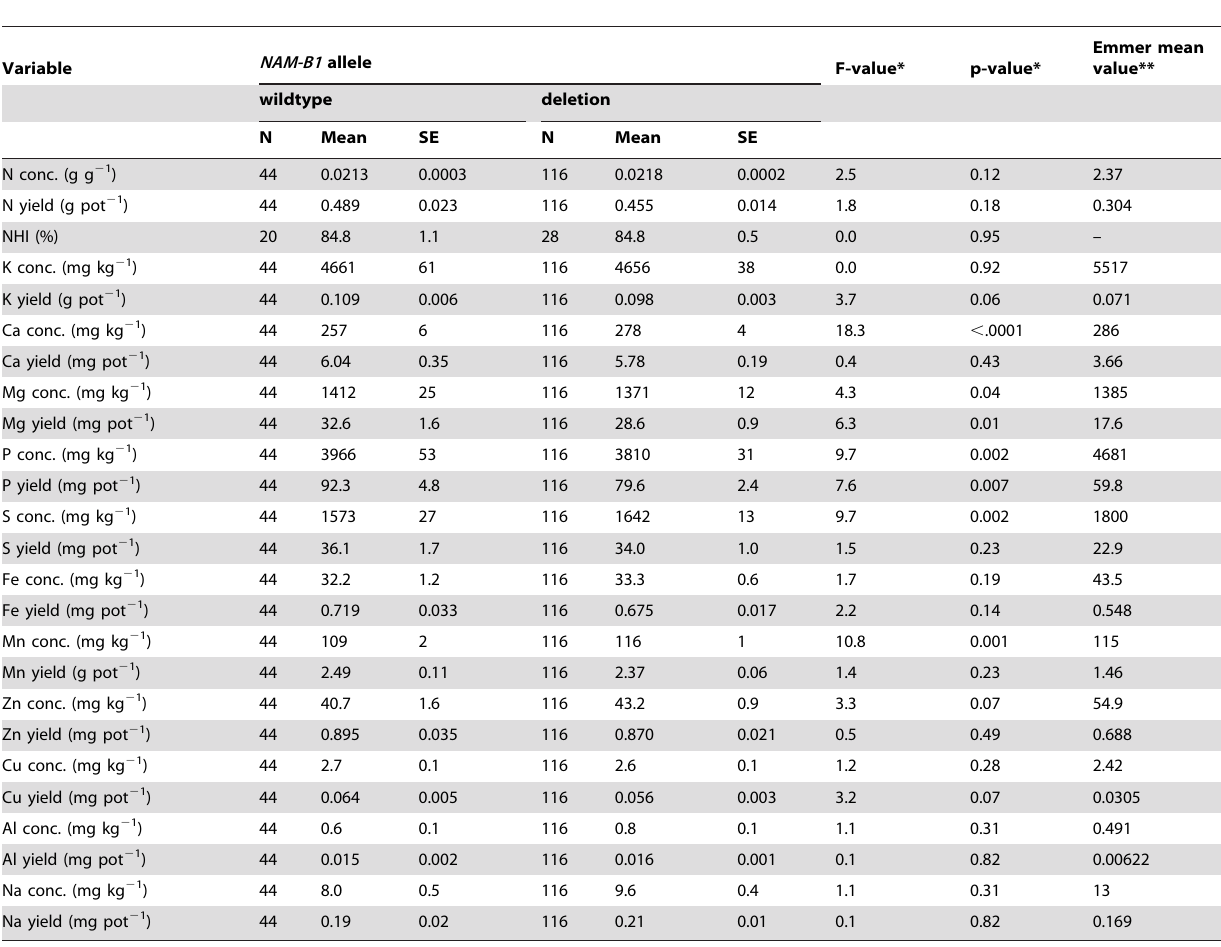
Table 3. Means of concentrations and total amount per pot of some minerals in the grains for the varieties grouped based on NAM-B1